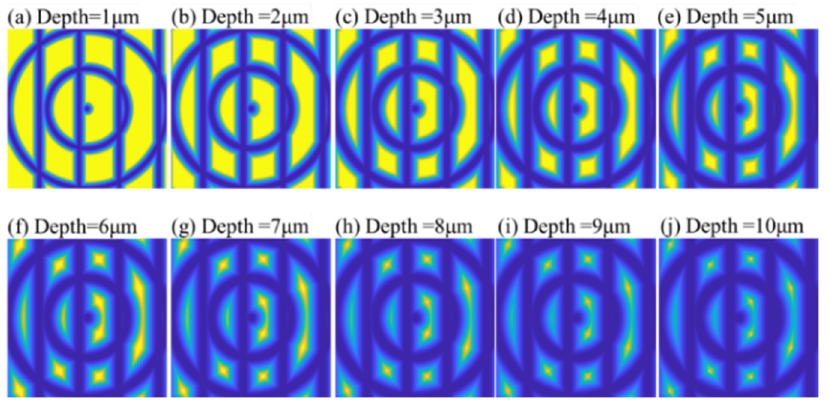
Figure 16. Comparison of the simulated surface topography of a polar microstructure with different depths of cut. Other important machining parameters: groove spacing: 50 μ m, tool nose radius: 50 μ m.